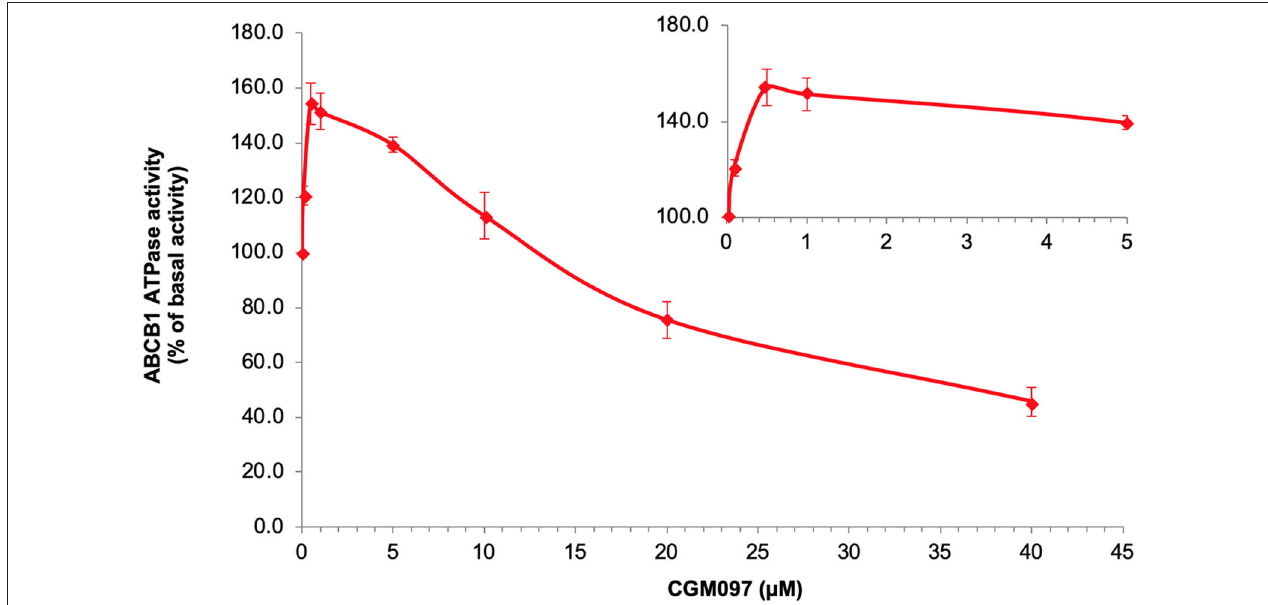
FIGURE 5 | NVP-CGM097 stimulate first and then inhibit the ATPase activity of ABCB1. Effect of various concentrations of NVP-CGM097 on the ATPase activity of ABCB1. The inset graphs illustrate the effect of 0–4 µ M NVP-CGM097 on the ATPase activity of ABCB1. Data are mean ± SD, representative of three independent